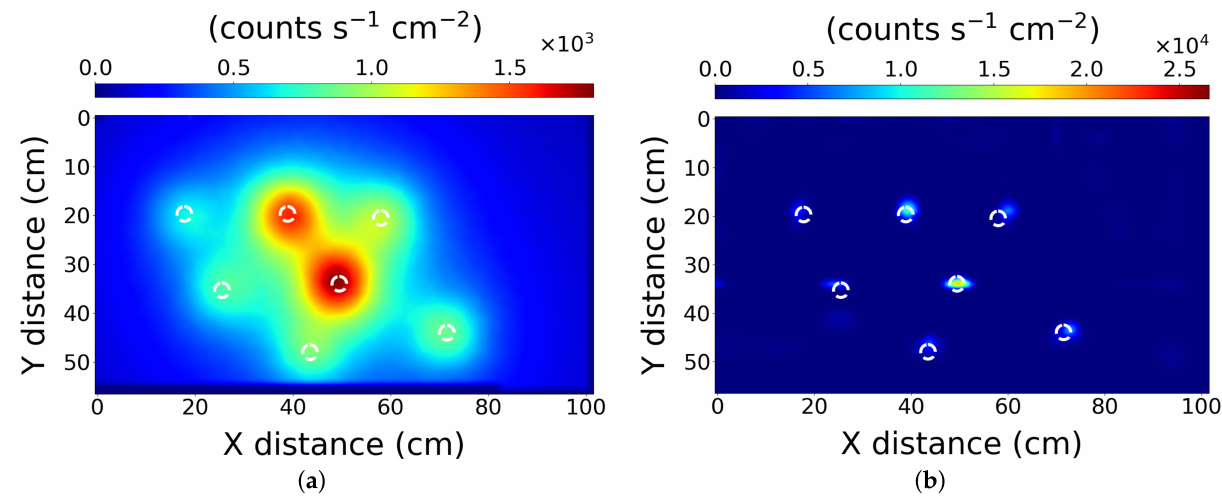
Figure 6. The results from scenario 4—Mixed source strengths. After processing with ( a ) simple interpolation, and ( b ) the PLR algorithm. The scan used a 1 cm resolution. The dashed white circles represent the true location of the source pucks.